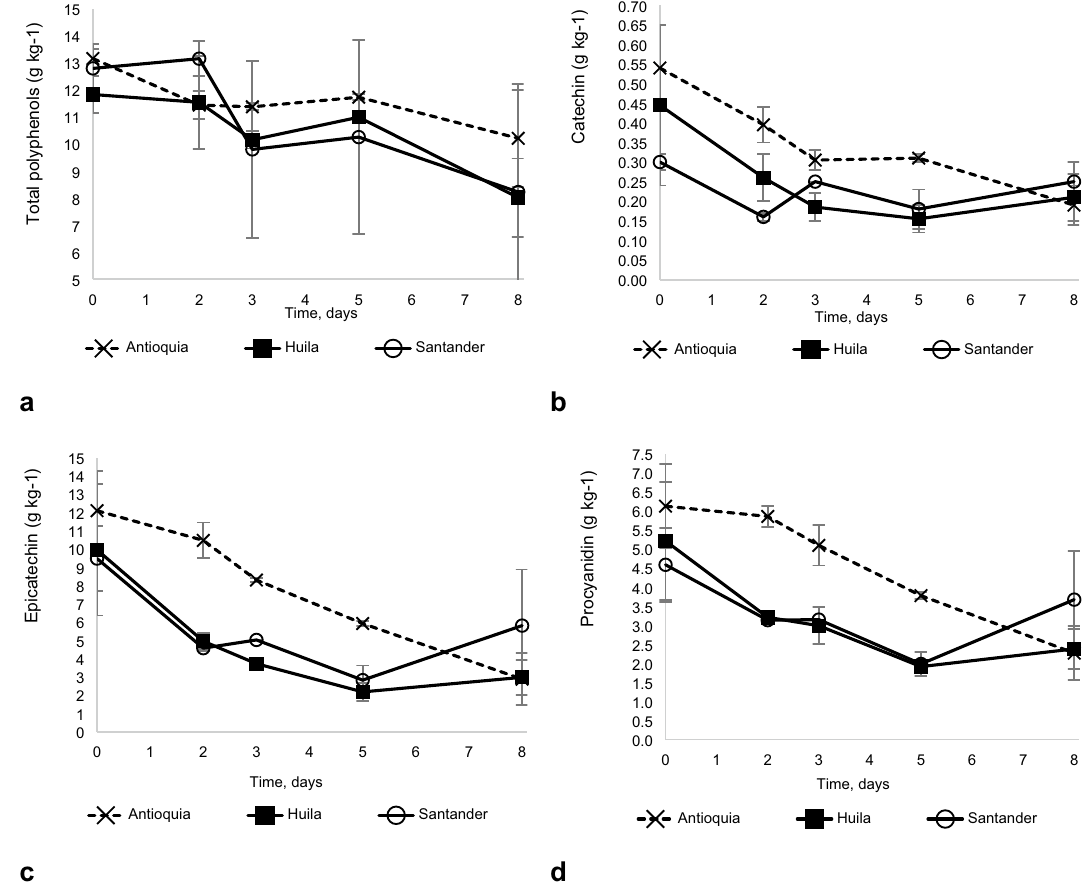
Figure 5. Dynamics of the polyphenols throughout the cocoa fermentation process in three locations: Antioquia, Huila, and Santander. ( a ) Total polyphenols, ( b ) Catechin, ( c ) Epicatechin and ( d )